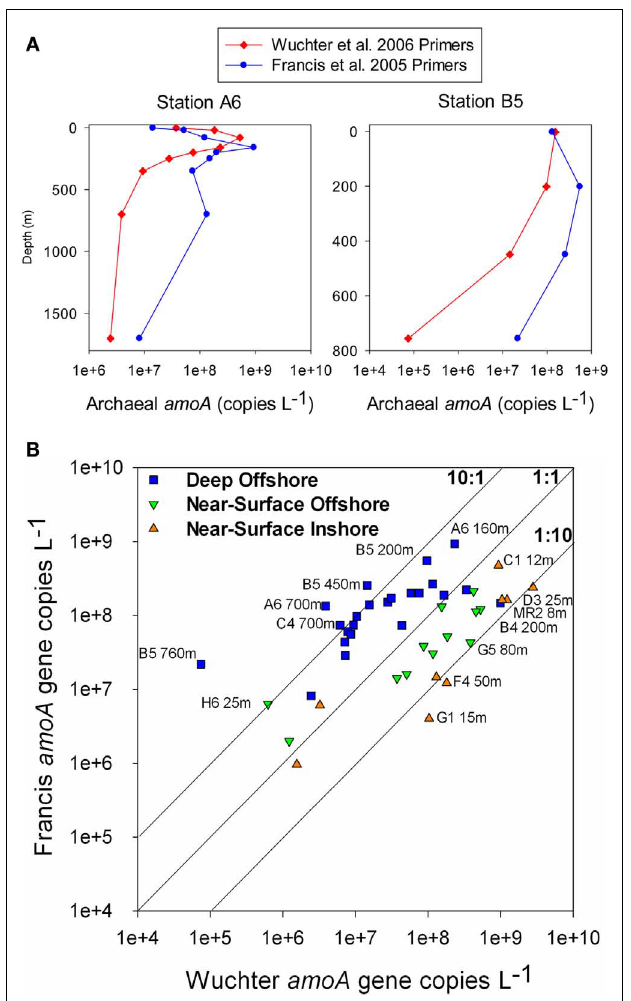
FIGUREA6 | Comparison ofArchaeal amoA gene abundance estimated by qPCR reactions with primers fromWuchter et al. (2006) or Francis et al. (2005). (A) Profiles of amoA abundance at Stations A6 and B5 • = Francis. (B) Abundance obtained using each primer set. (cid:7) = Wuchter, of amoA genes estimated using Francis primers versus abundance estimated using theWuchter primers. “Deep,” > 100m sample depth; “near-surface,” =≤ 100m sample depth; “inshore,” = above continental shelf; “offshore,” = shelf break and beyond. (A) Station profiles of amoA quantified with different primer sets (B) amoA quantified byWuchter et al. (2006) primers versus Francis et al. (2005) primers.